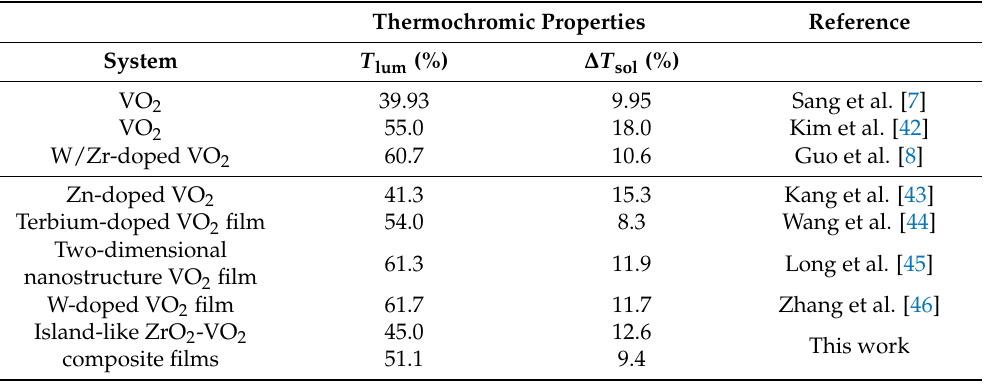
Figure 8. The electrical hysteresis loop ( a ) and the corresponding differential curves ( b ) of pure VO 2 film, sample ZrO 2 -90 W, and sample ZrO 2 -90 W-acid. Table 3. Comparison of thermochromic performance of this work with previous works.